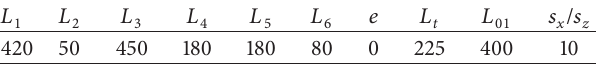
Table 2: The assumed manipulator structure parameters